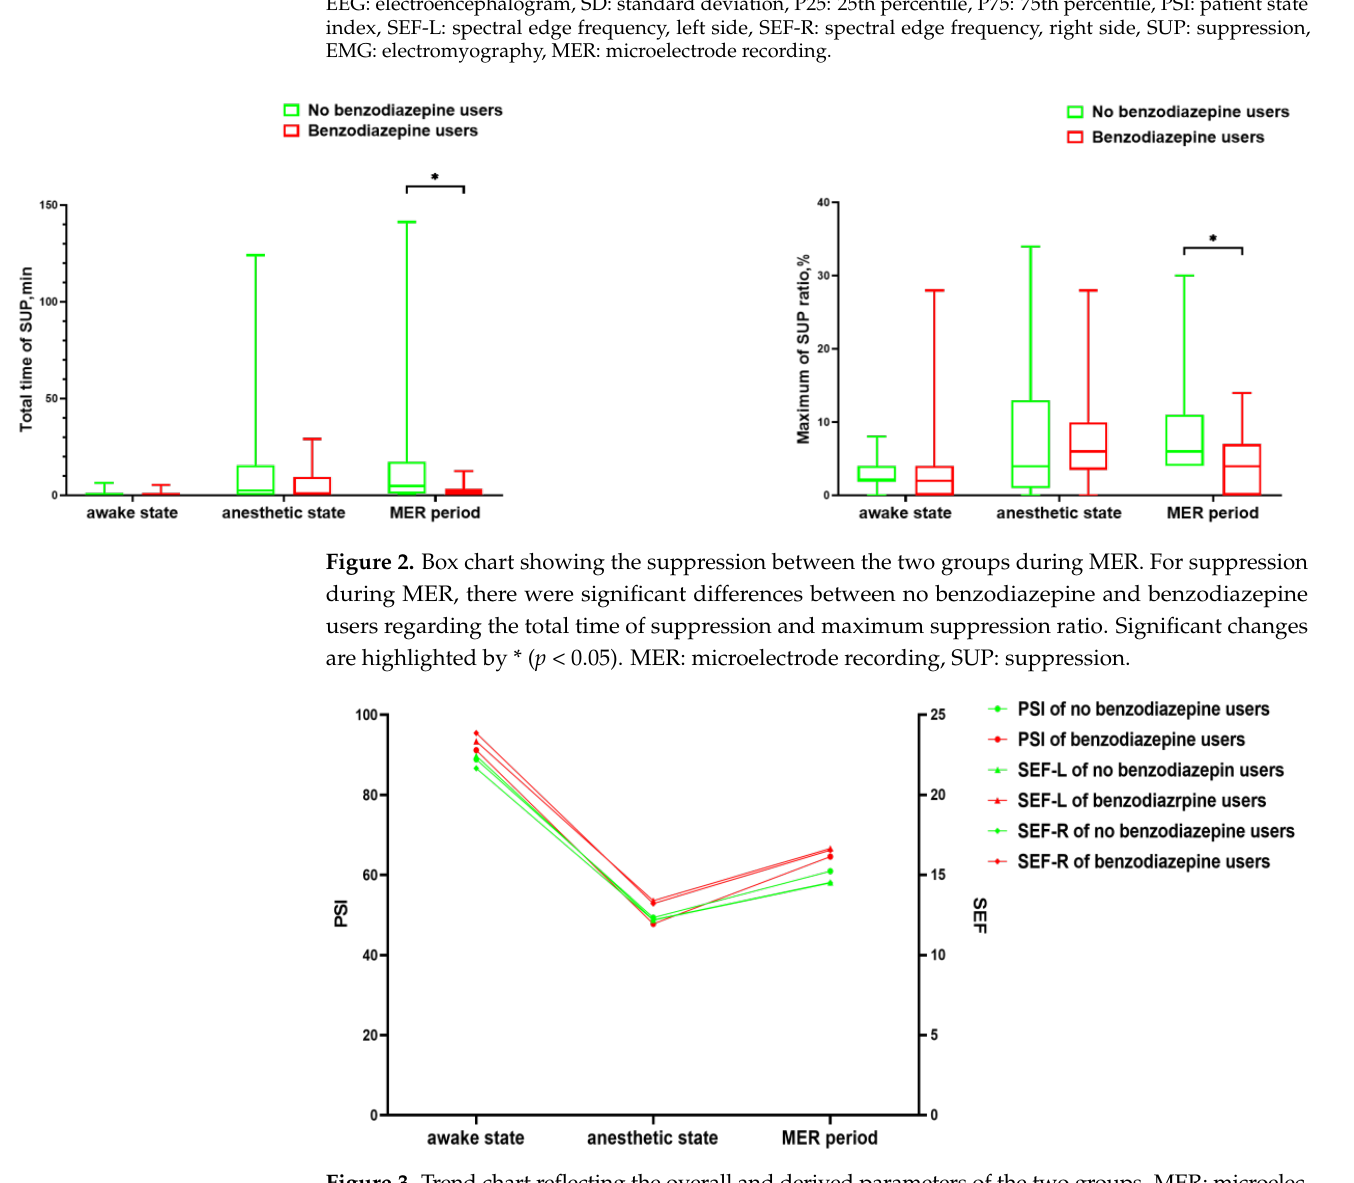
Figure 3. Trend chart reflecting the overall and derived parameters of the two groups. MER: microelectrode recording, PSI: patient state index, SEF-L: spectral edge frequency, left side, SEF-R: spectral edge frequency, right side.